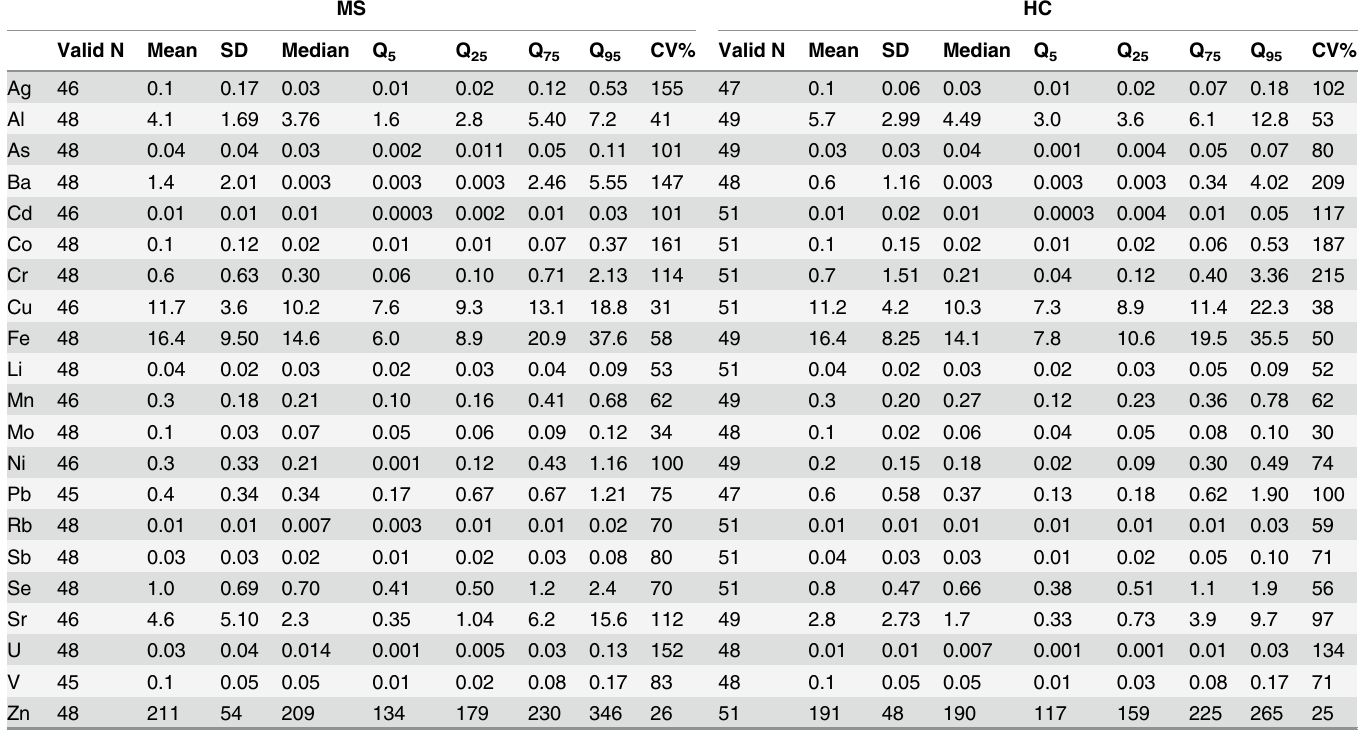
Table 3. Basic statistical parameters of trace element contents in scalp hair from Multiple Sclerosis patients (MS) and healthy controls